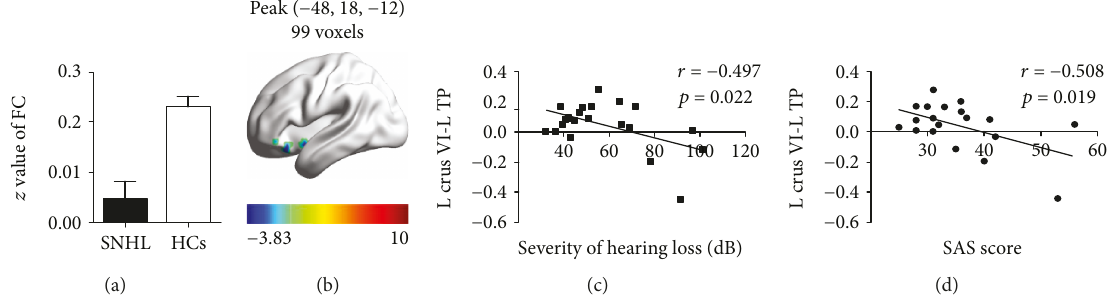
Figure 6: (a) Mean FC z values between left cerebellar crus VI and left TP. (b) Schematic of the left surface of the brain: coloured regions identify regions of reduced FC in left TP with left crus VI. (c) Voxel-wise correlations of FC z -score between left crus VI and left TP versus severity of hearing loss (dB). FC z -score between left cerebellar crus VI and left TP ( r =-0.497, p = 0 022 ). (d) Voxel-wise correlations of FC z -score between left crus VI and left TP versus SAS anxiety score (dB) ( r =-0.508, p = 0 019 ). SNHL: sensorineural hearing loss; HCs: healthy controls; TP: temporal pole; SAS: Self-Rating Anxiety Scale.